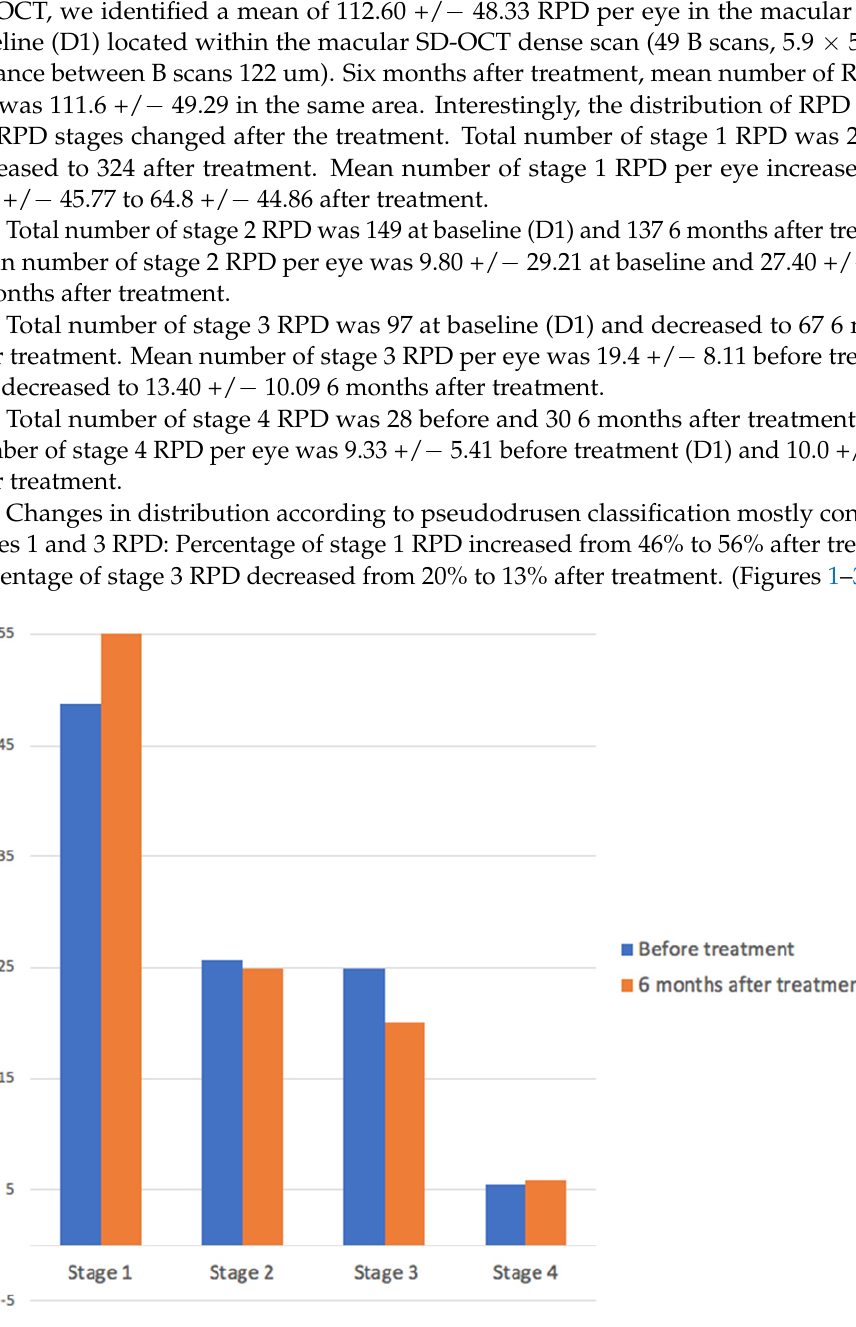
Figure 1. Percentage of reticular pseudodrusen (RPD) according to staging, before and 6 months after photobiomodulation treatment. Distribution of RPD among the RPD stages changed after the treatment. The number of stage 3 reticular pseudodrusen decreased while stage 1 reticular pseudodrusen increased after